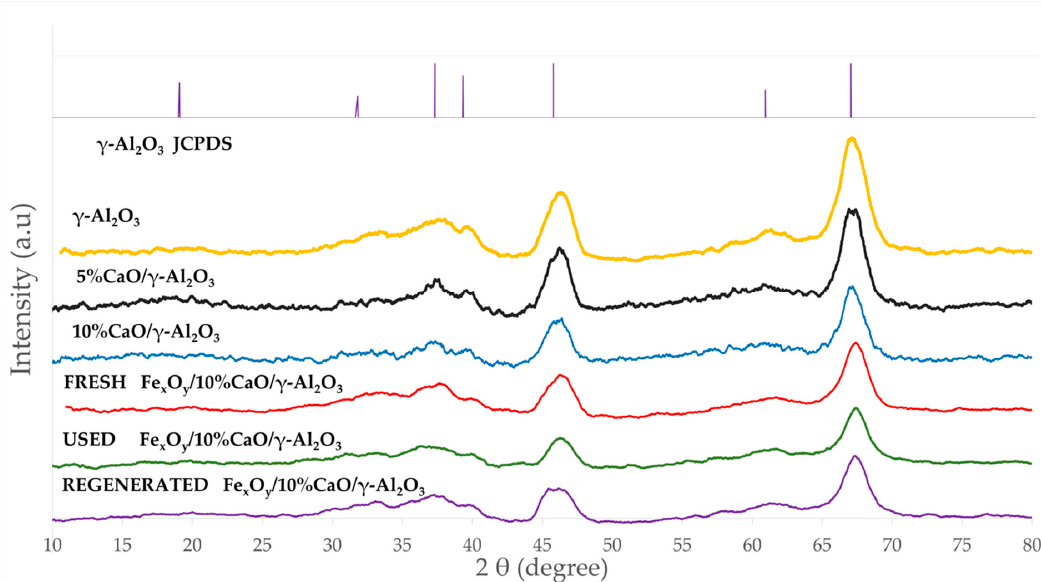
Figure 2. XRD diffractograms for the γ -Al 2 O 3 support, the catalyst precursor with CaO added to the γ -Al 2 O 3 support, the Fe x O y /CaO/ γ -Al 2 O 3 catalyst at various stages of catalyst utilization (fresh, after usage, and following regeneration).